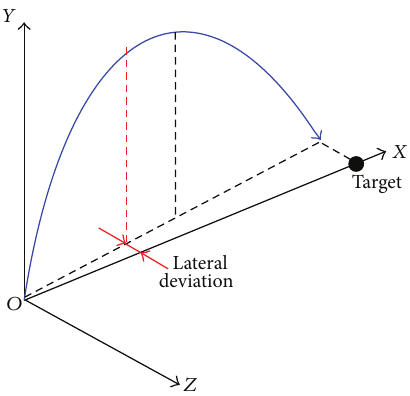
Figure 10: Lateral deviation in the ascending segment.